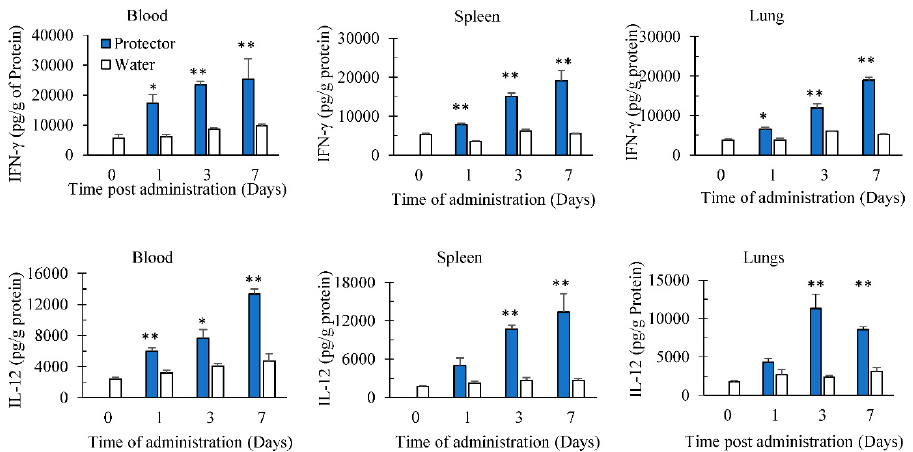
Figure 3. Oral administration of “Protector” for 1, 3 or 7 days significantly increased the production of IFN- γ and IL-12 in blood, spleen and lungs. Mice were orally administered a constant volume of sterile distilled water containing “Protector” (375 µg × 3/day) or nothing (control groups) for either 1, 3, or 7 days. Forty-eight hours later, tissues were obtained, processed for cytokine extraction, and then kept frozen until analysis. (* and ** indicate p < 0.05 and p < 0.01 to their time-point control (water), respectively).